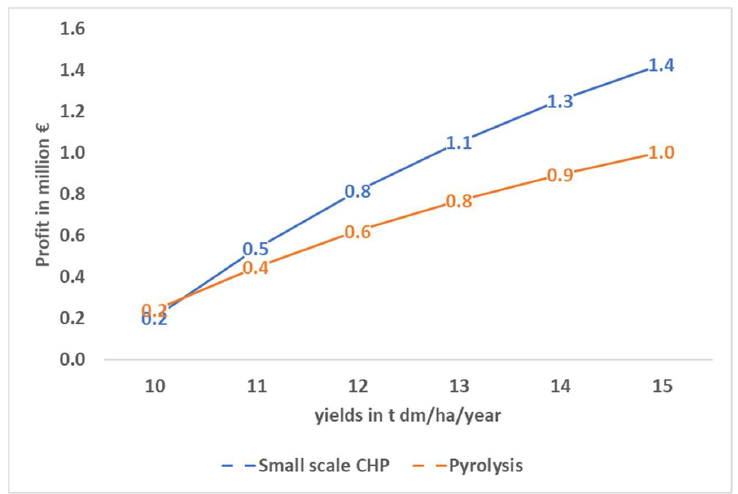
Figure 5. Annual profit (million € ) per million Euro investment in the two reference value chains by 192